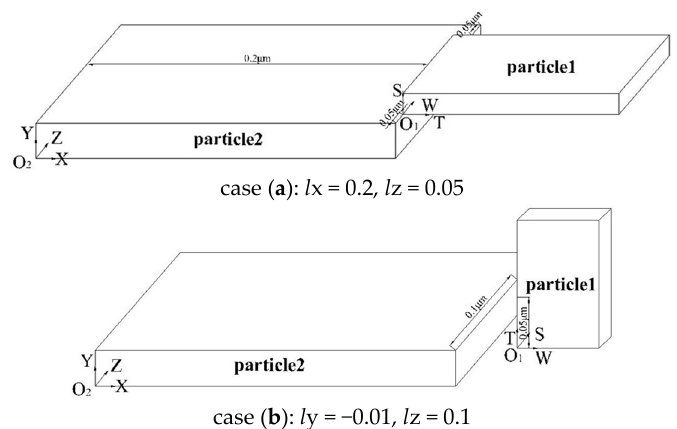
Figure 11. Two specific cases of edge-edge contact.